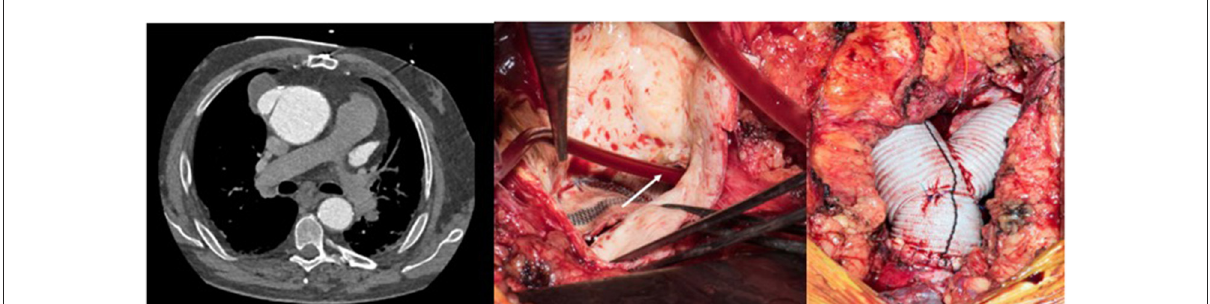
FIGURE12 Left: Pseudo-aneurysm at the proximal anastomosis of an ascending-descending bypass performed previously because of a recurrent coarctation. Middle: Intraoperative view after opening of the pseudo-aneurysm with the desinsertion of the anastomosis (*). The extra-anatomic bypass has been blocked proximally to the perfusion canula using a Fogarty catheter (white arrow). Right: View following replacement of the ascending aorta including an open arch distal anastomosis during circulatory arrest with bilateral antegrade cerebral perfusion and proximal extension of the extra-anatomic bypass to allow tensionless re-implantation in the ascending graft.